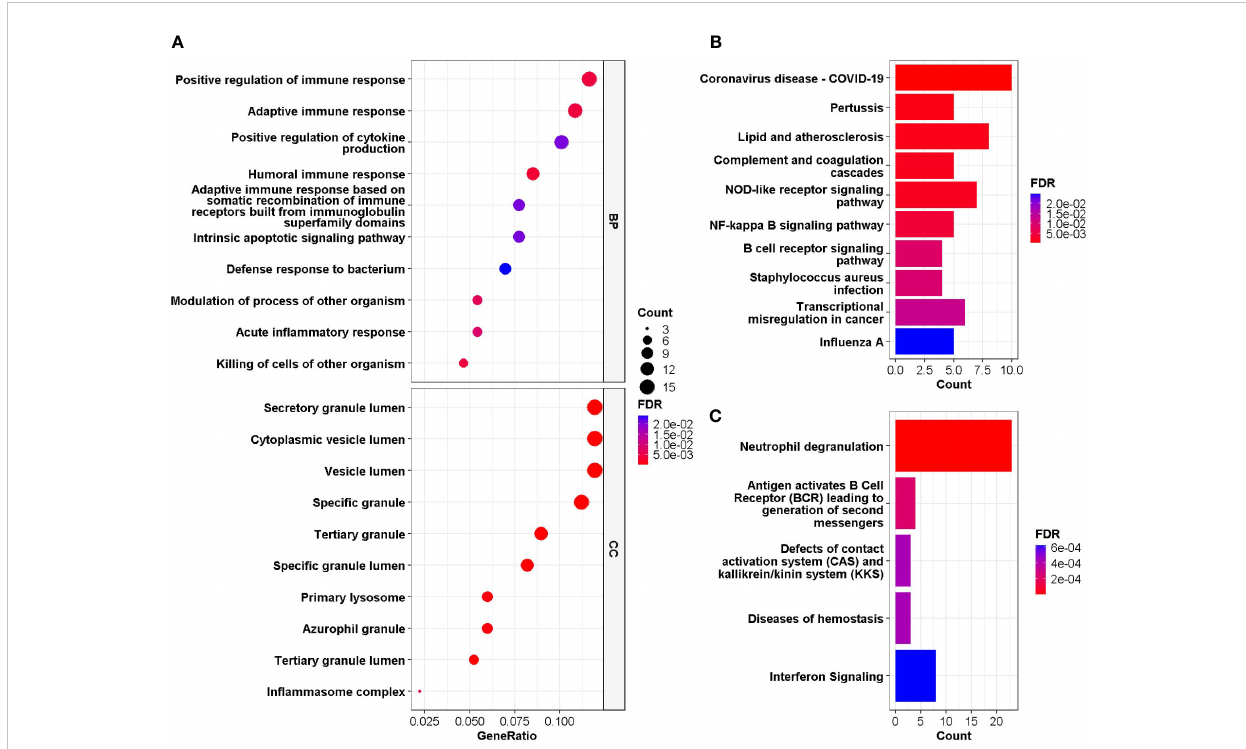
FIGURE 3 (A) GO enrichment analysis, where the horizontal axis represents the proportion of DEGs under the corresponding GO term. Top 10 pathways with most signi fi cant adjusted P-value were shown and ordered by gene ratio. BP, biological process; CC, cellular component. (B, C) GSEA of the common DEGs based on pathway database KEGG and REACTOME, where the horizontal axis represents the number of DEGs under the corresponding GSEA terms. Enrichment analysis applied Benjamini-Hochberg false discovery rate (FDR)-corrected P